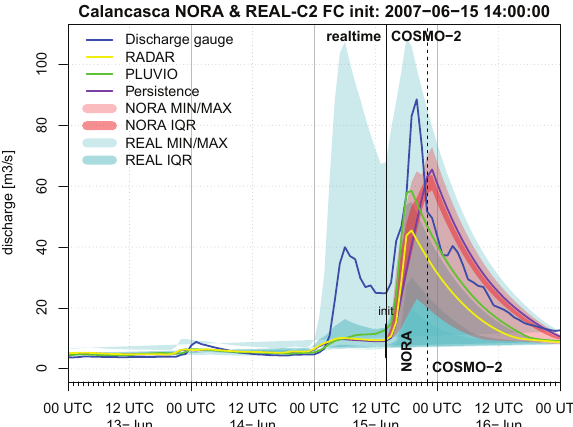
Fig. 8. Forecast simulation for the Calancasca initialised on 15 June at 14:00. For a description, see Fig.